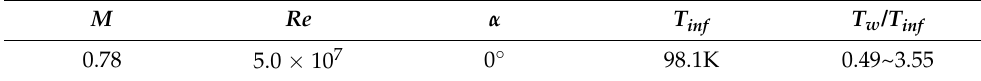
Table 4. Parameters of Case